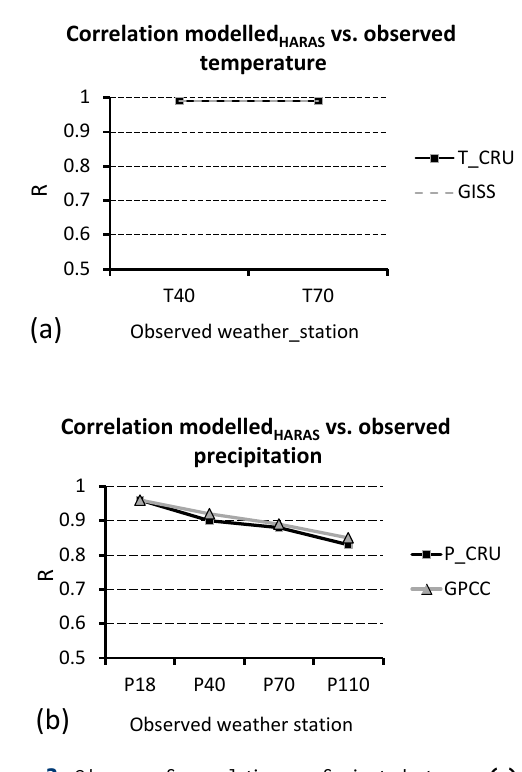
Figure 3. Change of correlation coefficients between (a) mod- elled monthly temperatures for Haras locality (T_CRU and GISS) and observed monthly temperatures (T40 and T70), (b) modelled monthly precipitation for Haras locality (P_CRU and GPCC) and observed monthly precipitation (P18, P40, P70 and P110), related to increasing distance of weather stations from Haras